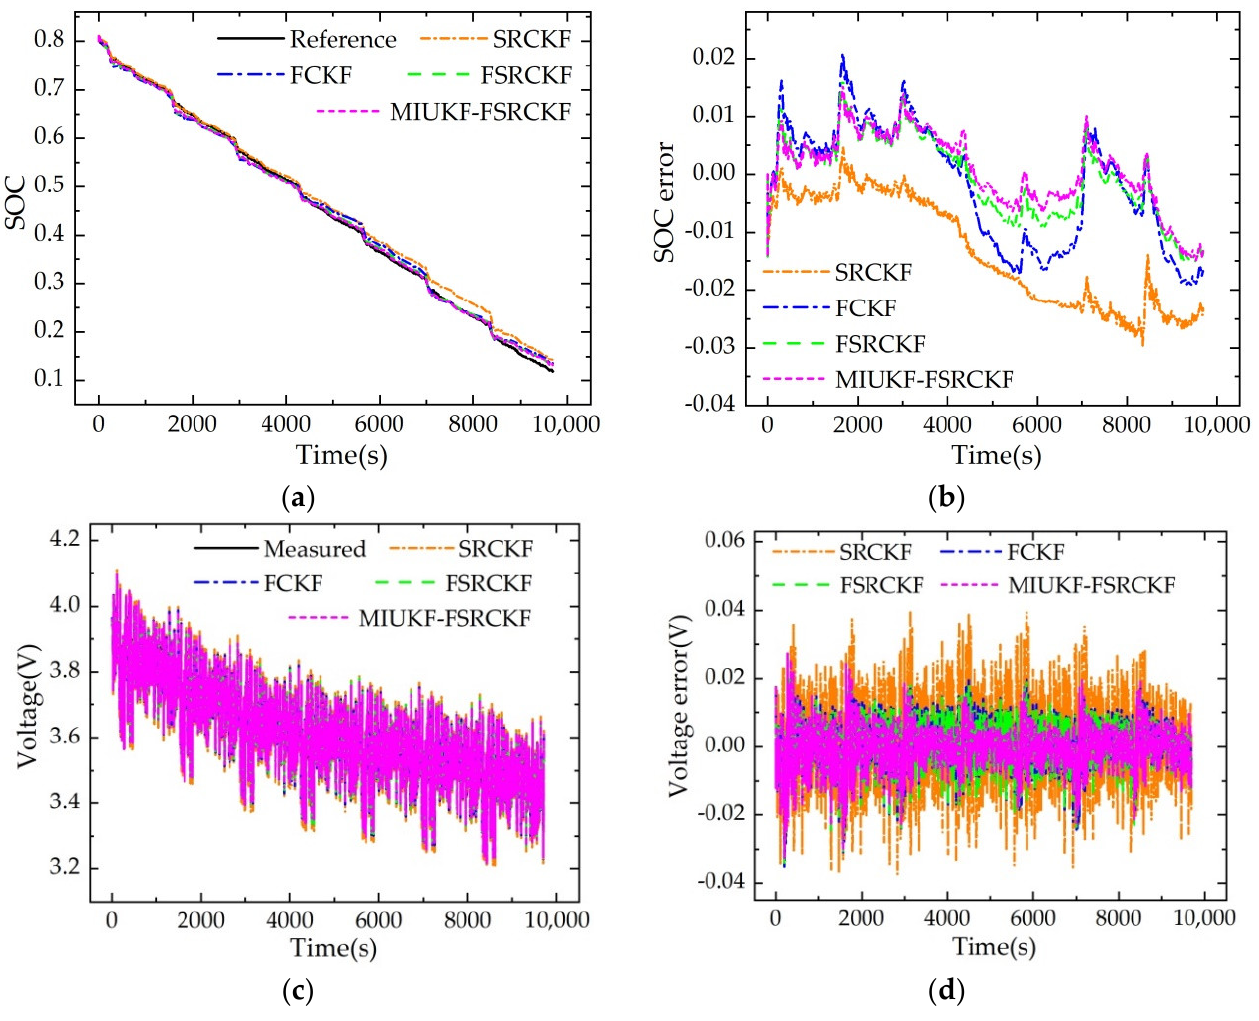
Table 3. SOC error and voltage error of each algorithm under the FUDS test.